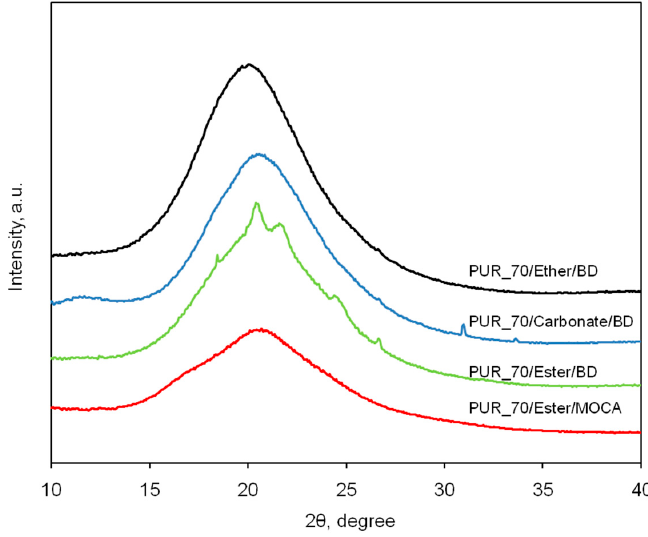
Figure 8. WAXS patterns of PUR with various chemical compositions. Contents of the soft segment for all materials is constant (SS = 70 wt %).